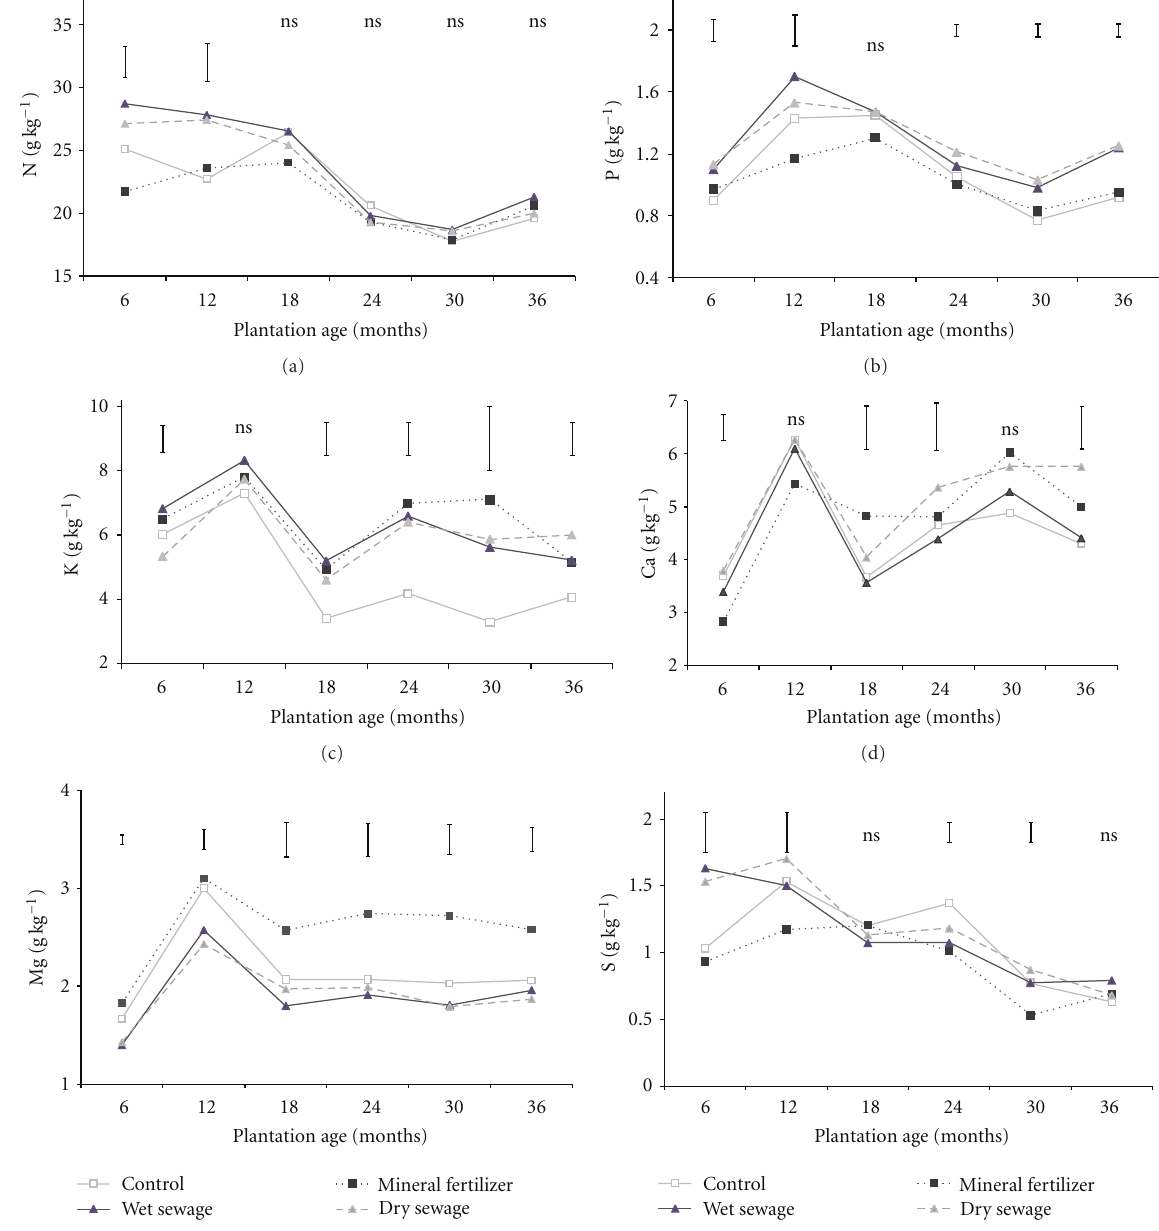
Figure 1: Nutrient concentrations within leaves sampled at 6, 12, 18, 24, 30 and 36 months after planting. Vertical bars represent the minimum significant value (Tukey— P < . 05) and ns mean a not significant di ff erence.